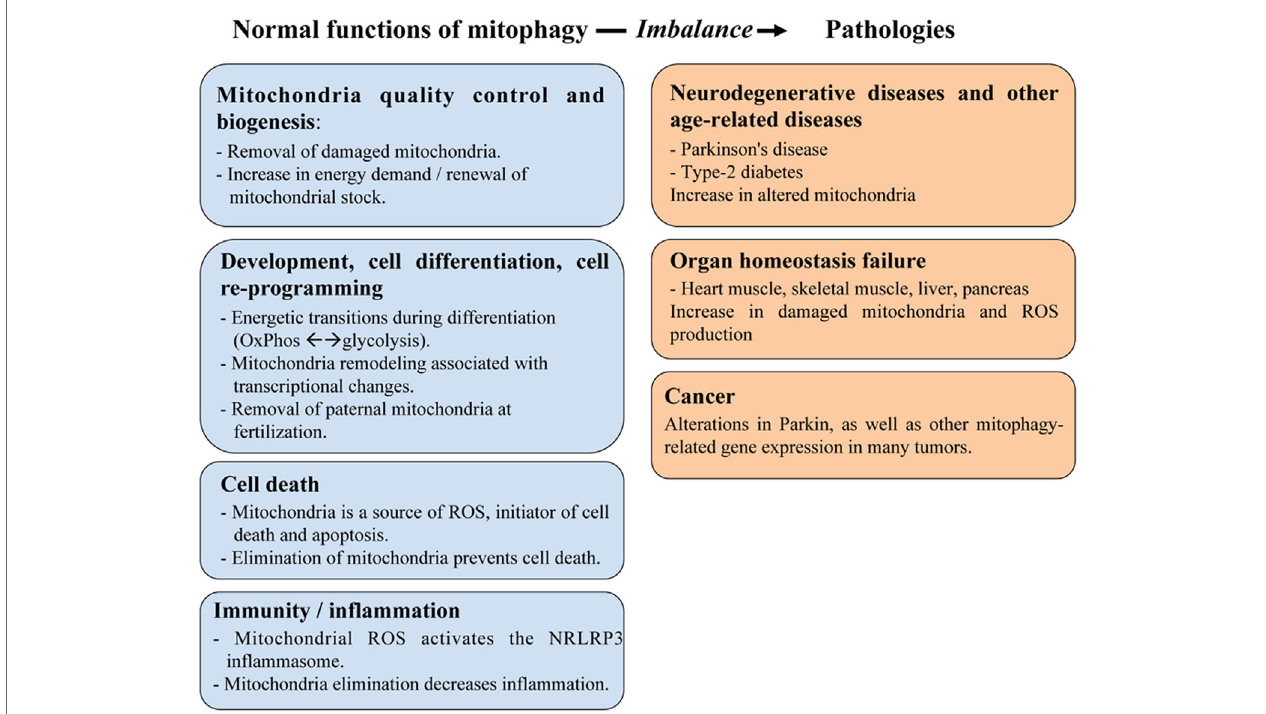
FigURe 1 | The role of mitophagy in physiology and human pathologies. Mitophagy plays an important role in maintaining mitochondria homeostasis including quality control of mitochondria and cell metabolism, as well as in regulating various aspects of cellular function, such as development/differentiation, cell death, and immunity/inflammation. These roles are critical to prevent developing human diseases linked to organ failure (heart muscle, skeletal muscle, liver, and pancreas) or to age-related dysfunctions (cancer, neurodegenerative